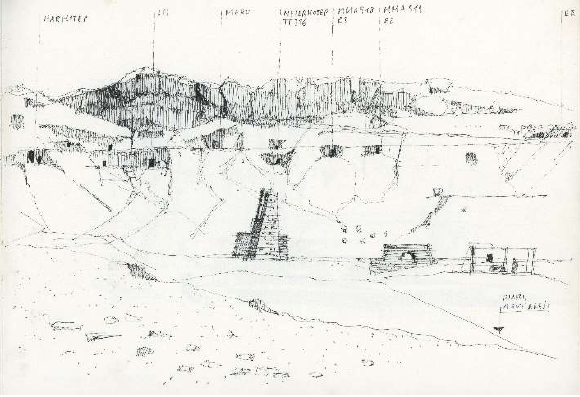
Figure 1. Design of Deir el-Bahari archaeologic area.